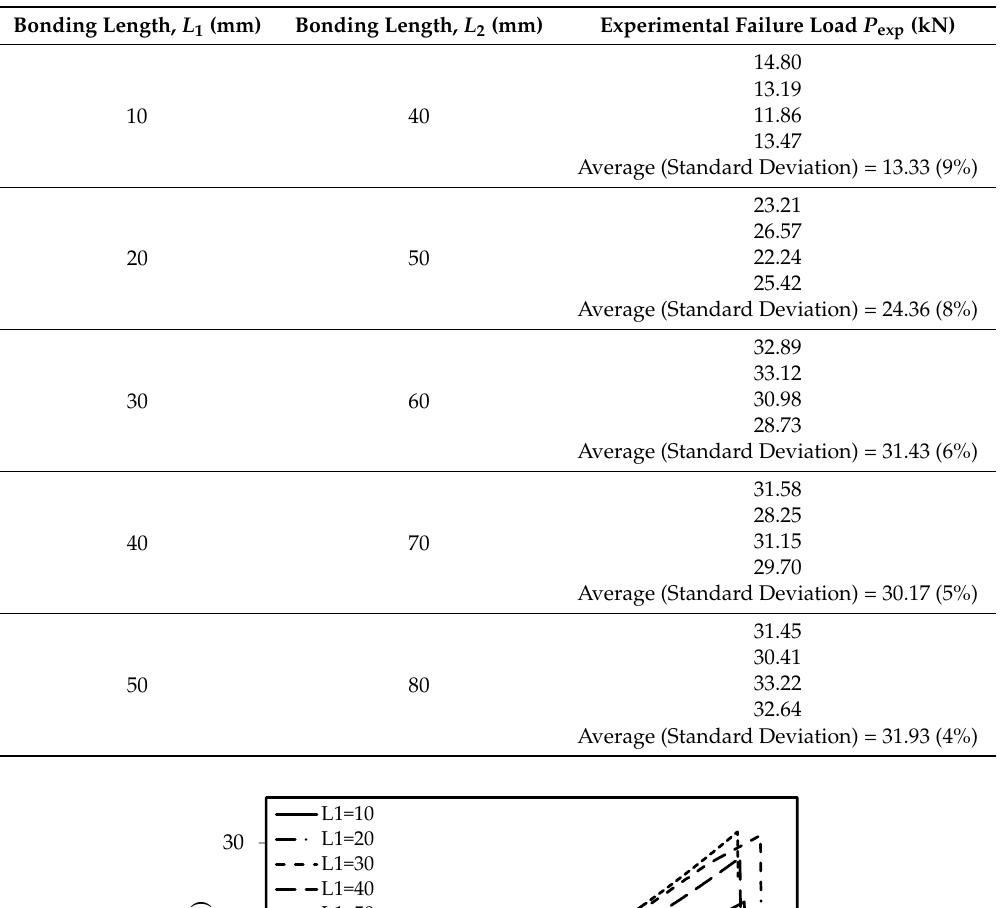
Table 2. Details of experimental failure loads for the tested double strap joints (DSJs).